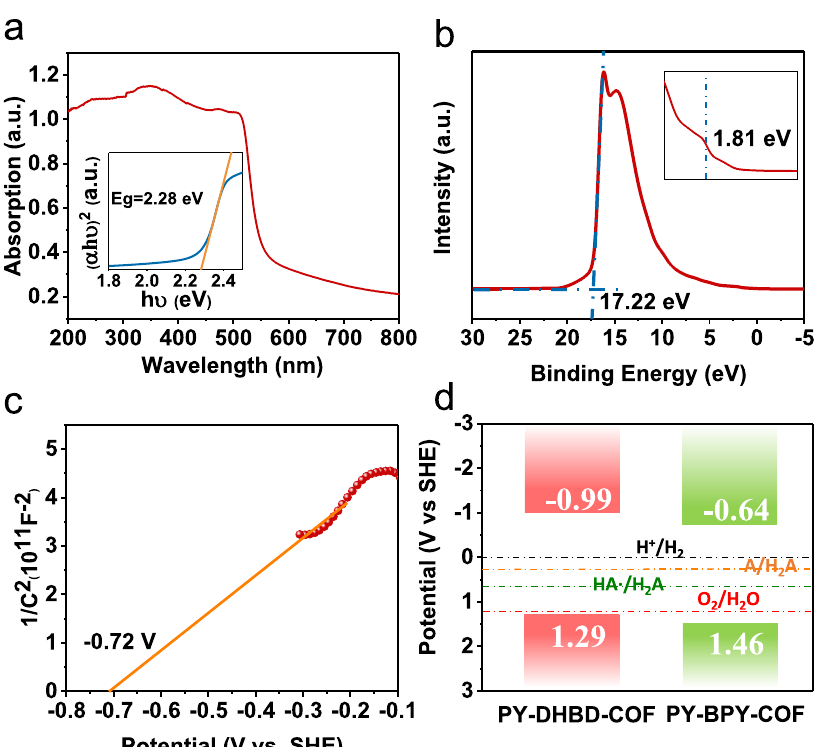
Fig. 3 Optical and electronic properties of typical samples. a UV-Vis diffuse re fl ectance spectrum of PY-DHBD-COF. Insert: Tauc plot in the form of ( α h υ ) 2 versus h υ . b UPS spectrum of PY-DHBD-COF. c Mott – Schottky plots of PY-DHBD-COF. d Energy band positions of COFs.